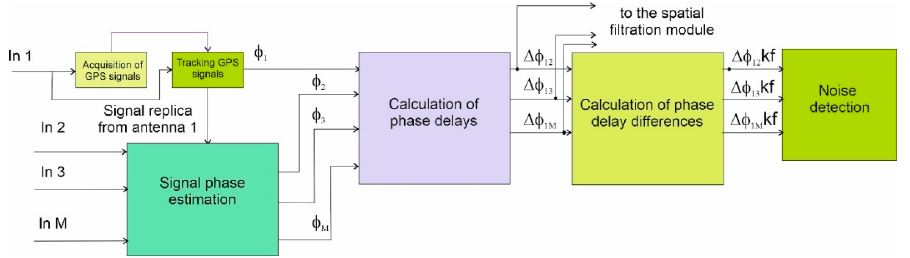
Figure 3. Schematic of noise detection block from the LTE signal.